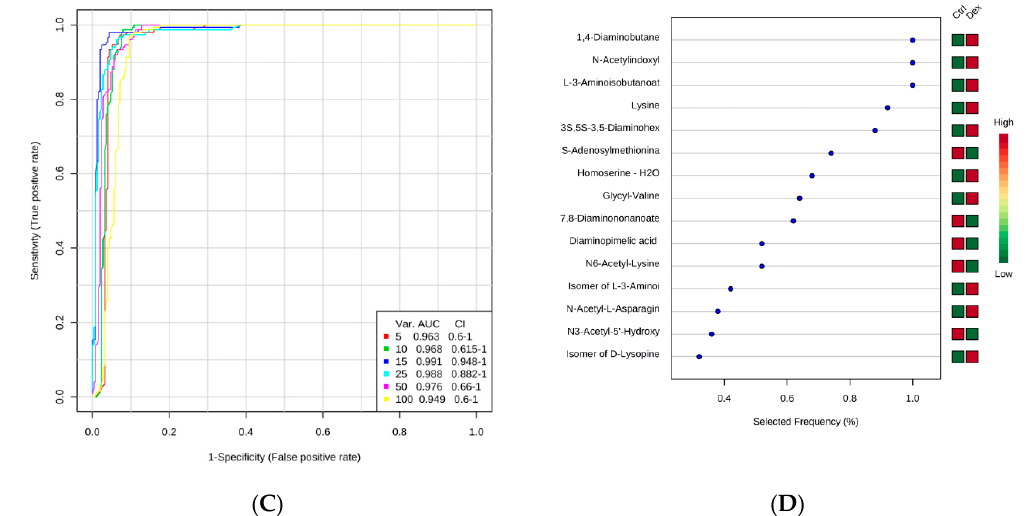
Figure 5. Rat skeletal muscle tissue submetabolomic profile after prolonged treatment with dexamethasone (Dex). ( A ) OPLS-DA score plot ( Q 2 = 0.928, R 2 = 0.990) shows a clear separation between healthy muscle tissue (Ctrl, n = 6) and Dex-treated groups ( n = 5). Tissue samples were run on LC-MS in duplicate. ( B ) Volcano plot shows the statistically significant altered metabolites (FDR-corrected p -value < 0.05, and FC > 1.2 or < 0.83). The levels of 268 metabolites (red) were increased and 174 were decreased (blue) in Dex-treated rats compared to controls. ( C ) The ROC curve was generated by the OPLS-DA model, with AUC values calculated from the combination of 5, 10, 15, 25, 50, and 100 metabolites. ( D ) Frequency plot shows 15 positively identified metabolites.